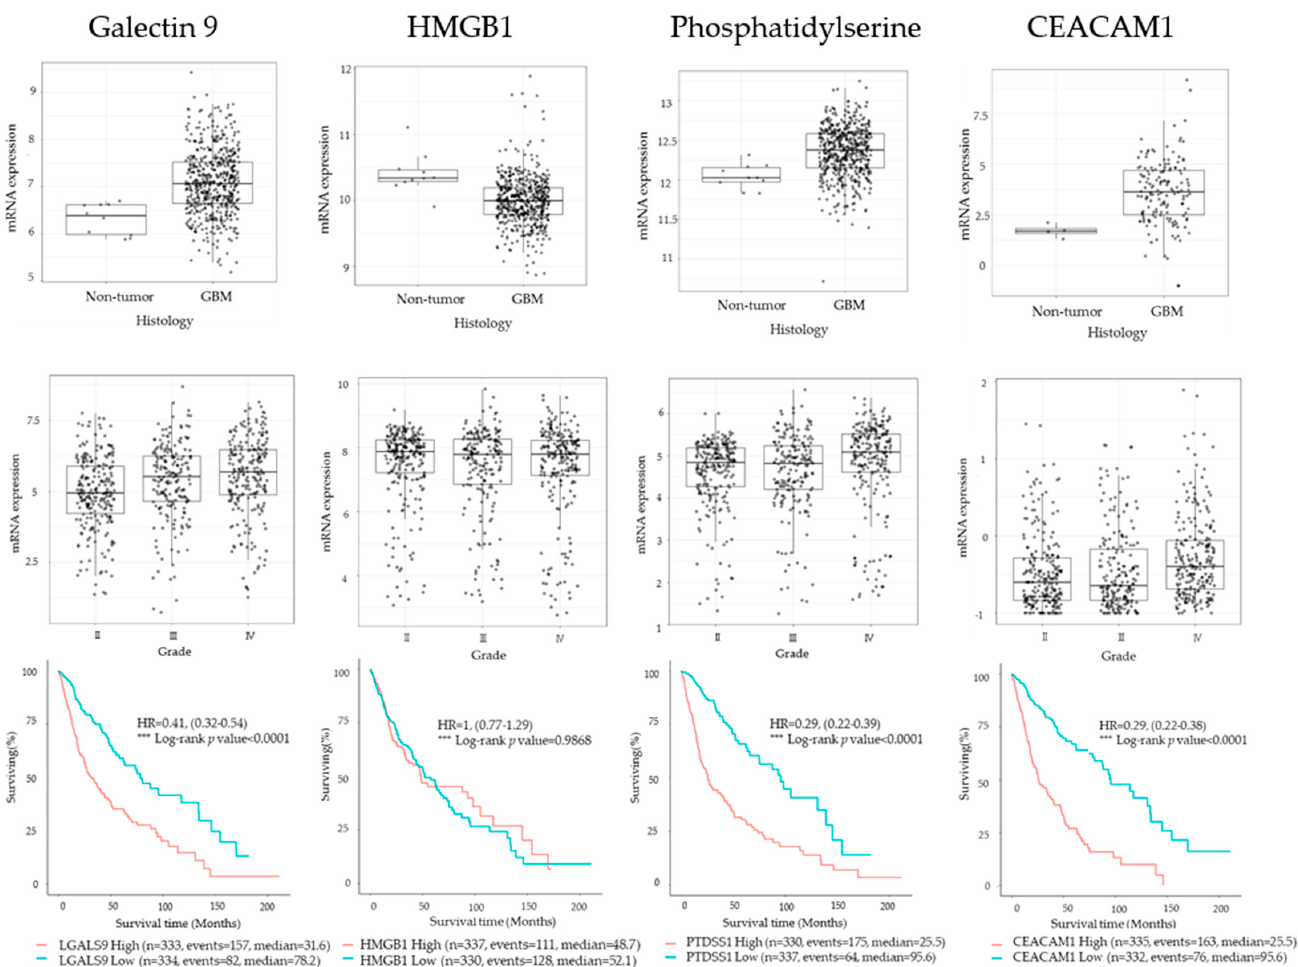
Figure 1. Expression of the TIM3 ligands, Galectin 9, Phosphatidylserine, HMGB1 and CEACAM1 in gliomas in TCGA data set. Top: mRNA expression of TIM3 ligands in non-tumor and GBM samples. Middle: mRNA expression of TIM3 ligands according to disease stage. Bottom: Kaplan–Meier curves based on TIM3 ligands expression.